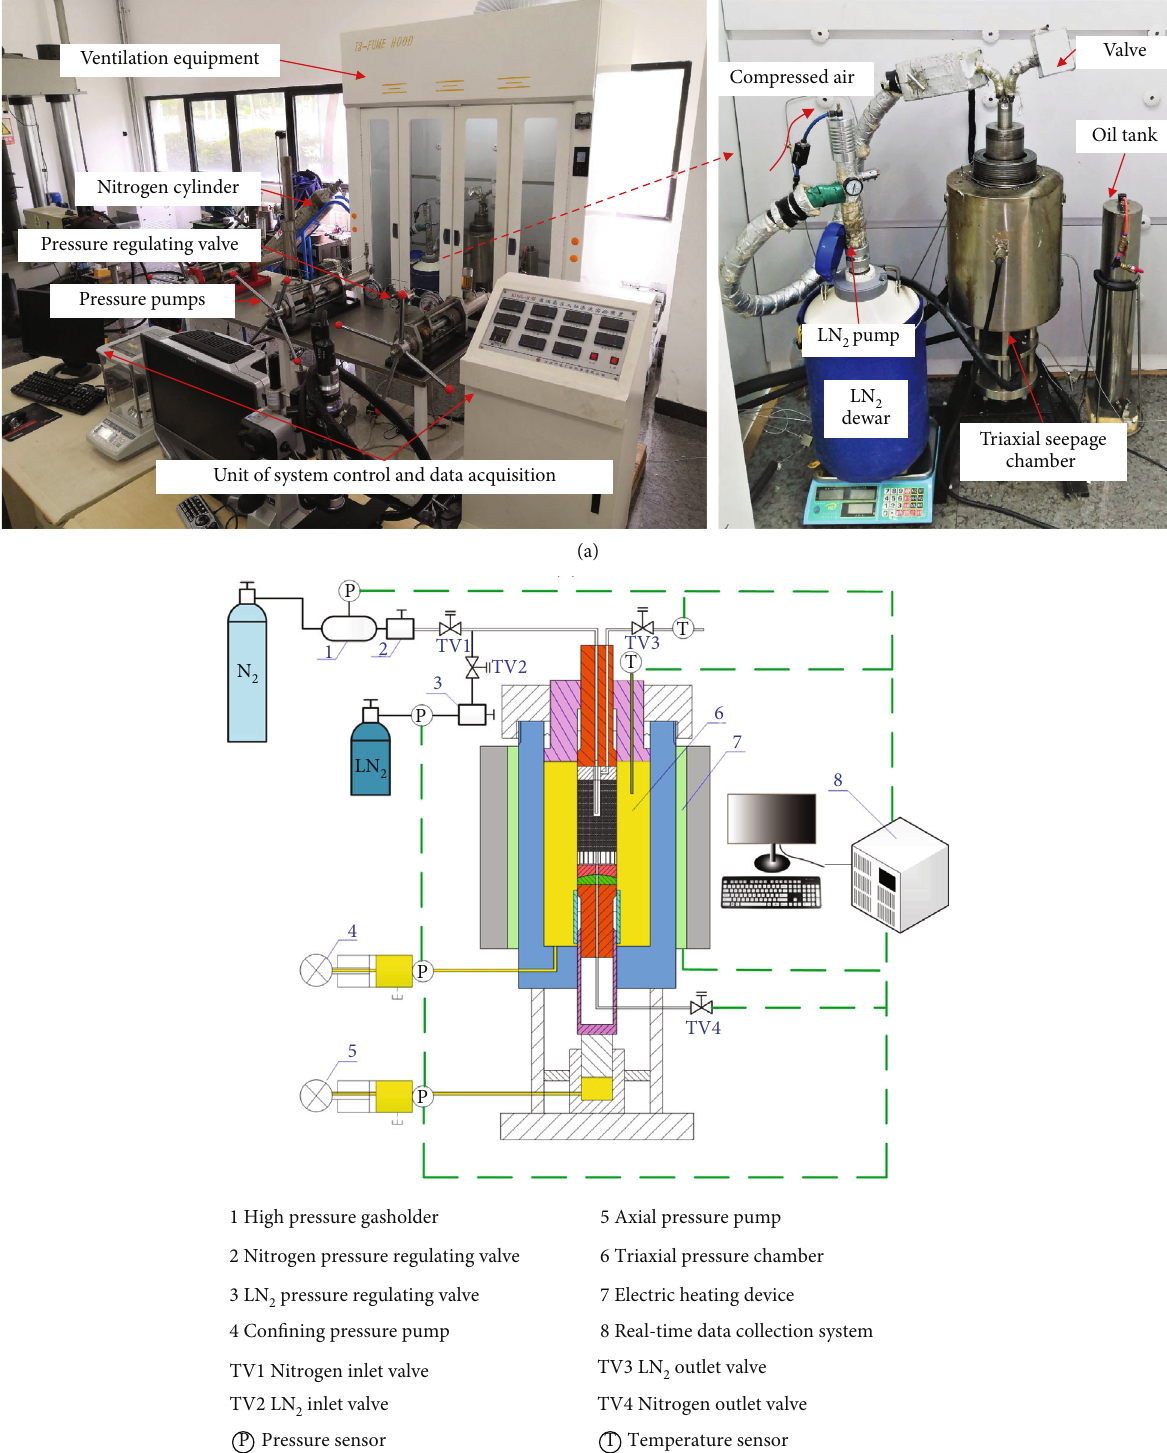
Figure 4: (a) The experimental device. (b) Diagram of real triaxial seepage and fracturing